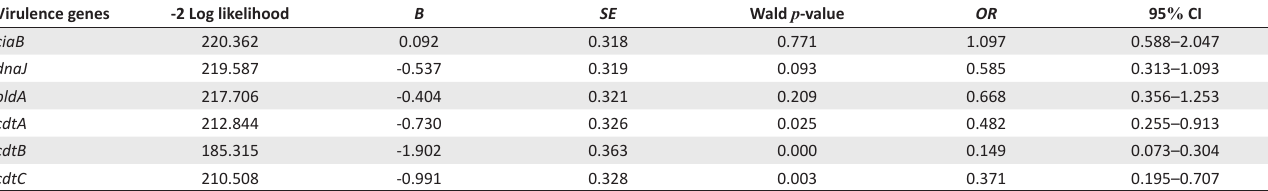
TABLE 4: Logistic regression analysis results demonstrating the significance of virulence genes found in human clinical isolates and chicken faeces. Virulence